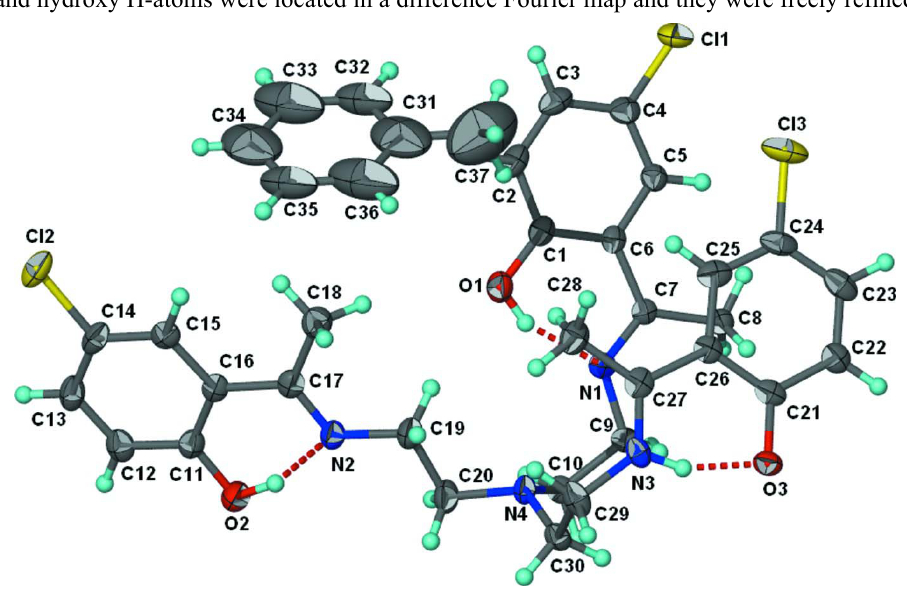
H Cl N O 3. 0.5C H at the 70% probability level. Hydrogen atoms 30 33 3 4 7 8